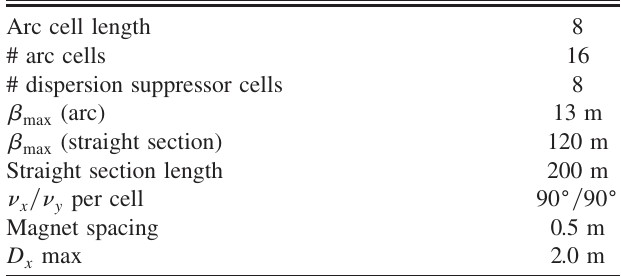
TABLE V. Decay ring